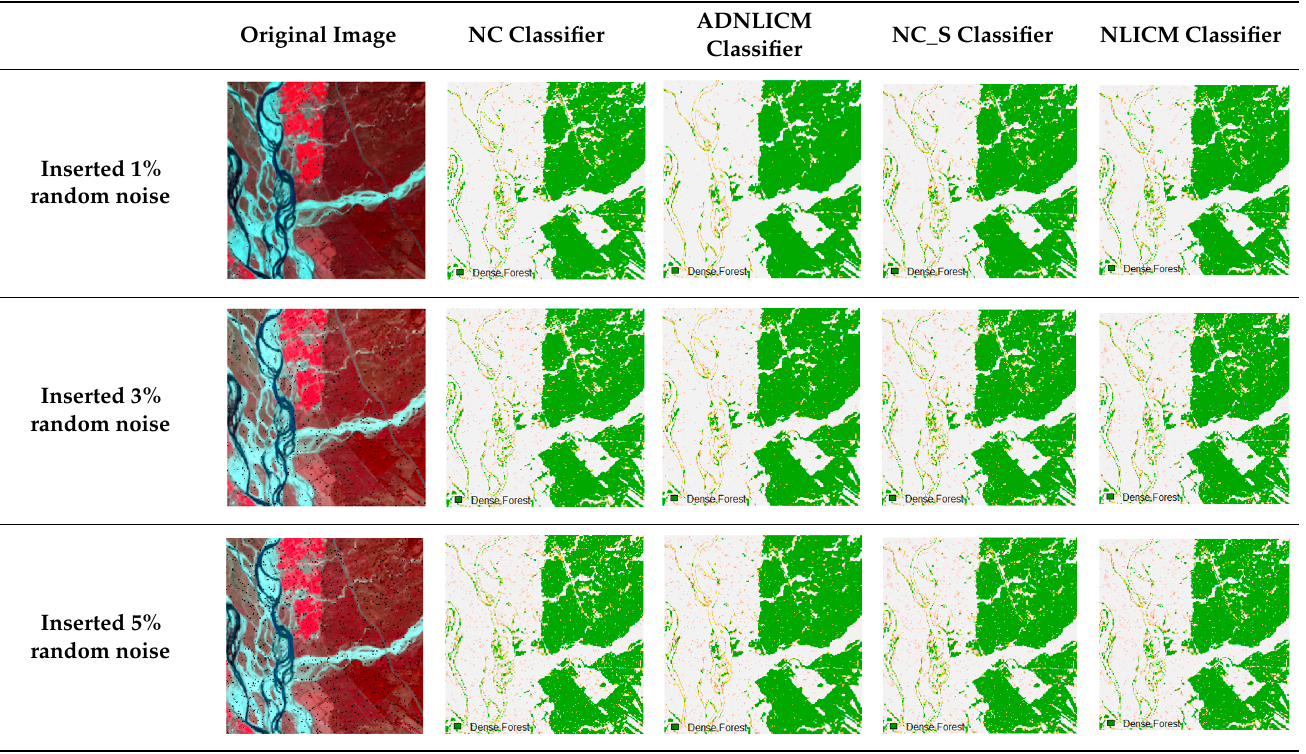
Table 6. Landsat-8 original and dense forest classified class image with respect to different random pepper noise (for site 1 (Haridwar)).